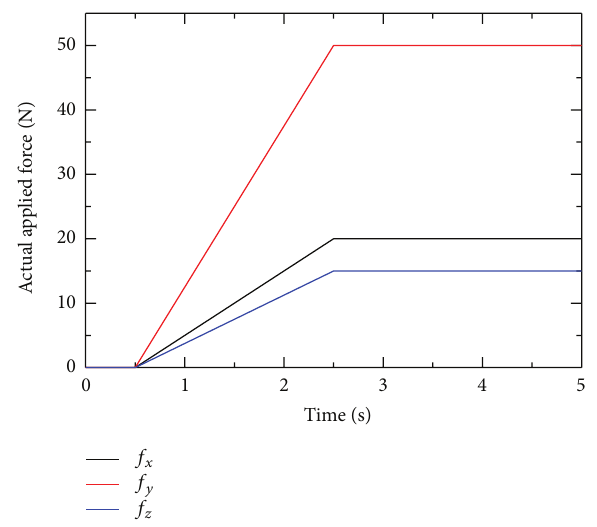
Figure 11: Actual applied force, F